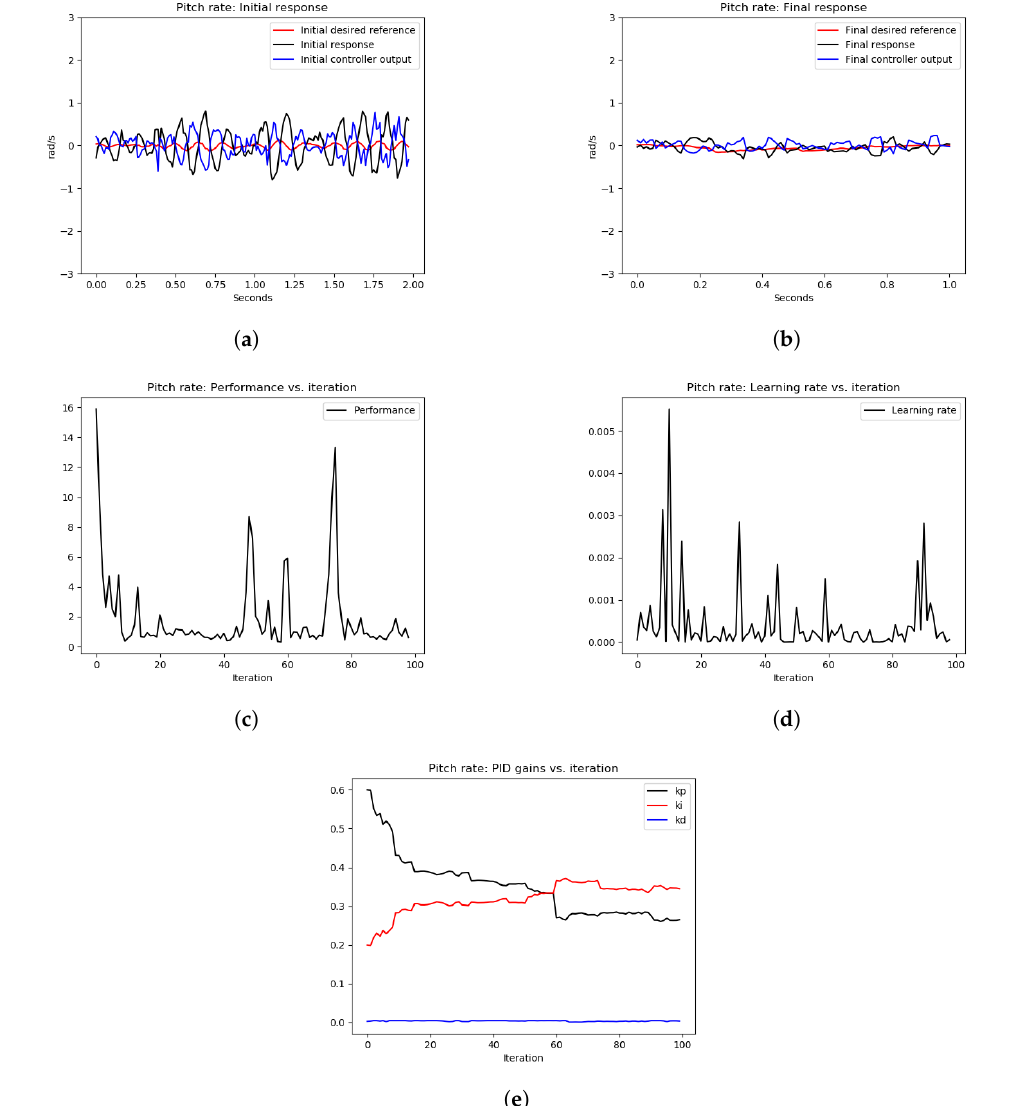
Figure 13. The results of the tuning process of the pitch rate PID controller in Experiment 2. ( a ) signals before tuning, ( b ) signals after tuning, ( c ) performance error V ( E ) over iterations, ( d ) learning rate α over tuning iterations, ( e ) PID